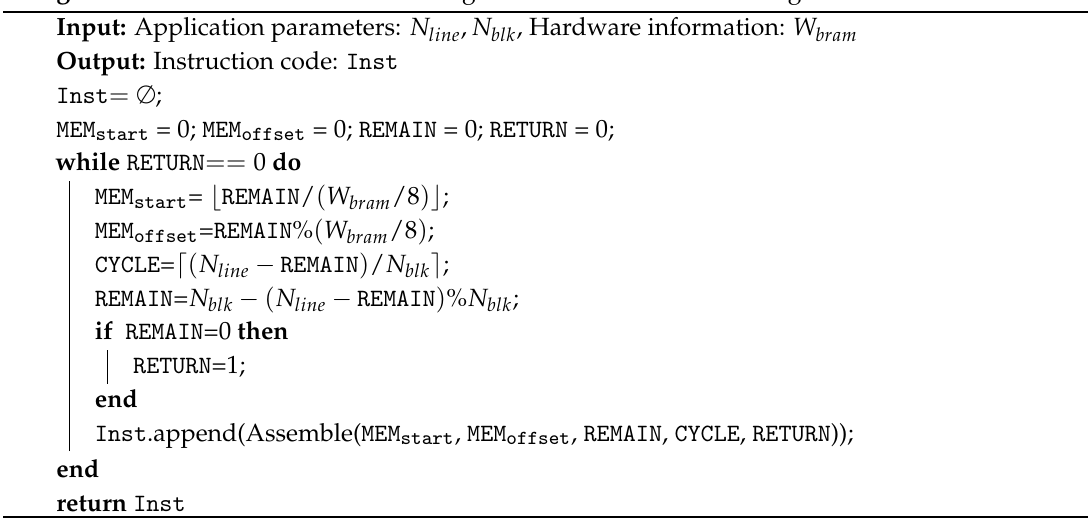
Algorithm 1: Instruction Generation Algorithm in D-SWIM Streaming